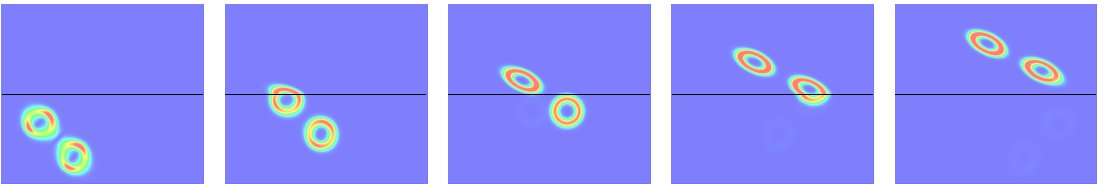
Figure 13. Refraction of a toroidal-vortex at the interface of (cid:101) 2 / (cid:101) 1 = 2.50 with the incident angle of 45 ◦ .